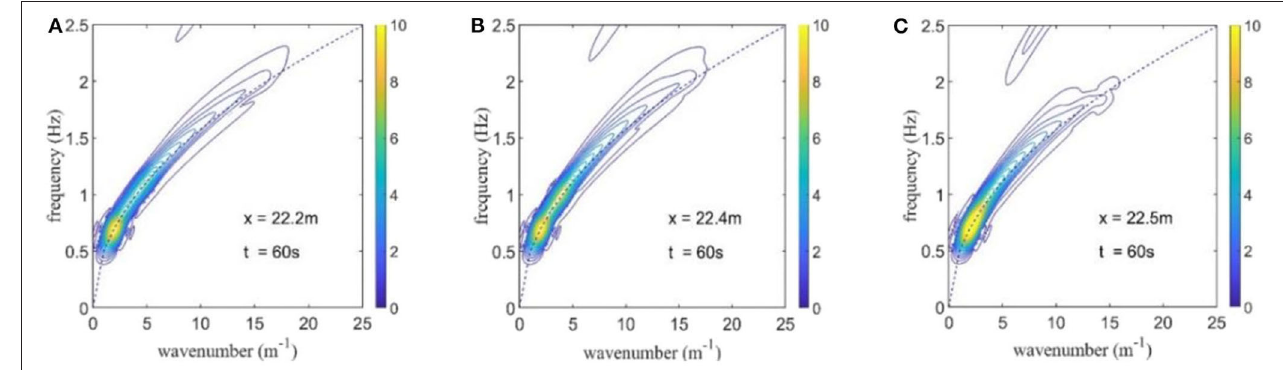
FIGURE 14 | Wavenumber-frequency spectra at the focusing location of odd-order components for different cases (blue dashed lines indicate the linear dispersion relationship). (A) Case 1_AB, (B) Case 2_AB, (C) Case 3_AB.